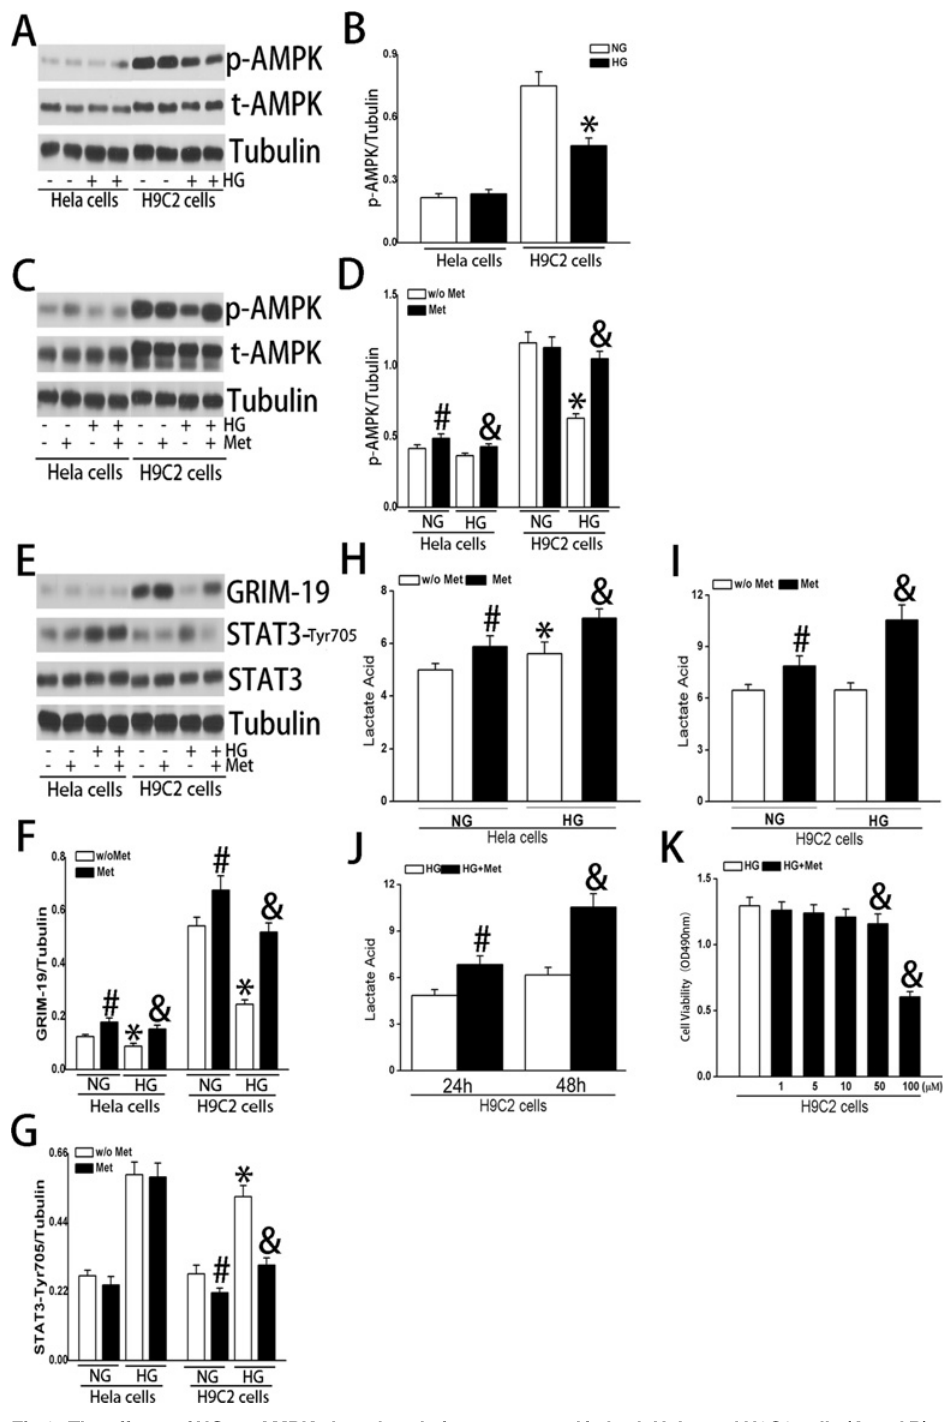
Fig 8. The effects of HG on AMPK phosphorylation were tested in both HeLa and H9C2 cells (A and B) and the effects of metformin on phosporylation of AMPK in the setting of HG were also tested (C and D). The effects of metformin on phosphorylation level of STAT3 and GRIM-19 were also quantified for both HeLa and H9C2 cells (E-G). The effects of metformin on lactate acid production were also evaluated for both HeLa cells (H) and H9C2 (I) cells. The time dependent (J) and dose dependent effects of metformin on lactate acid production were also demonstrated in H9C2 cells. Data are obtained from three independent experiments and expressed as mean ± SD. * denotes a P < 0 . 05 , compared with cells with NG culture medium; # P < 0 . 05 compared with HG cultured cells without